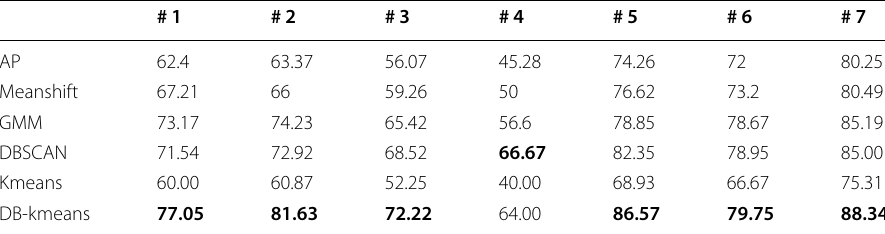
Bold values are the results of the method proposed in this paper